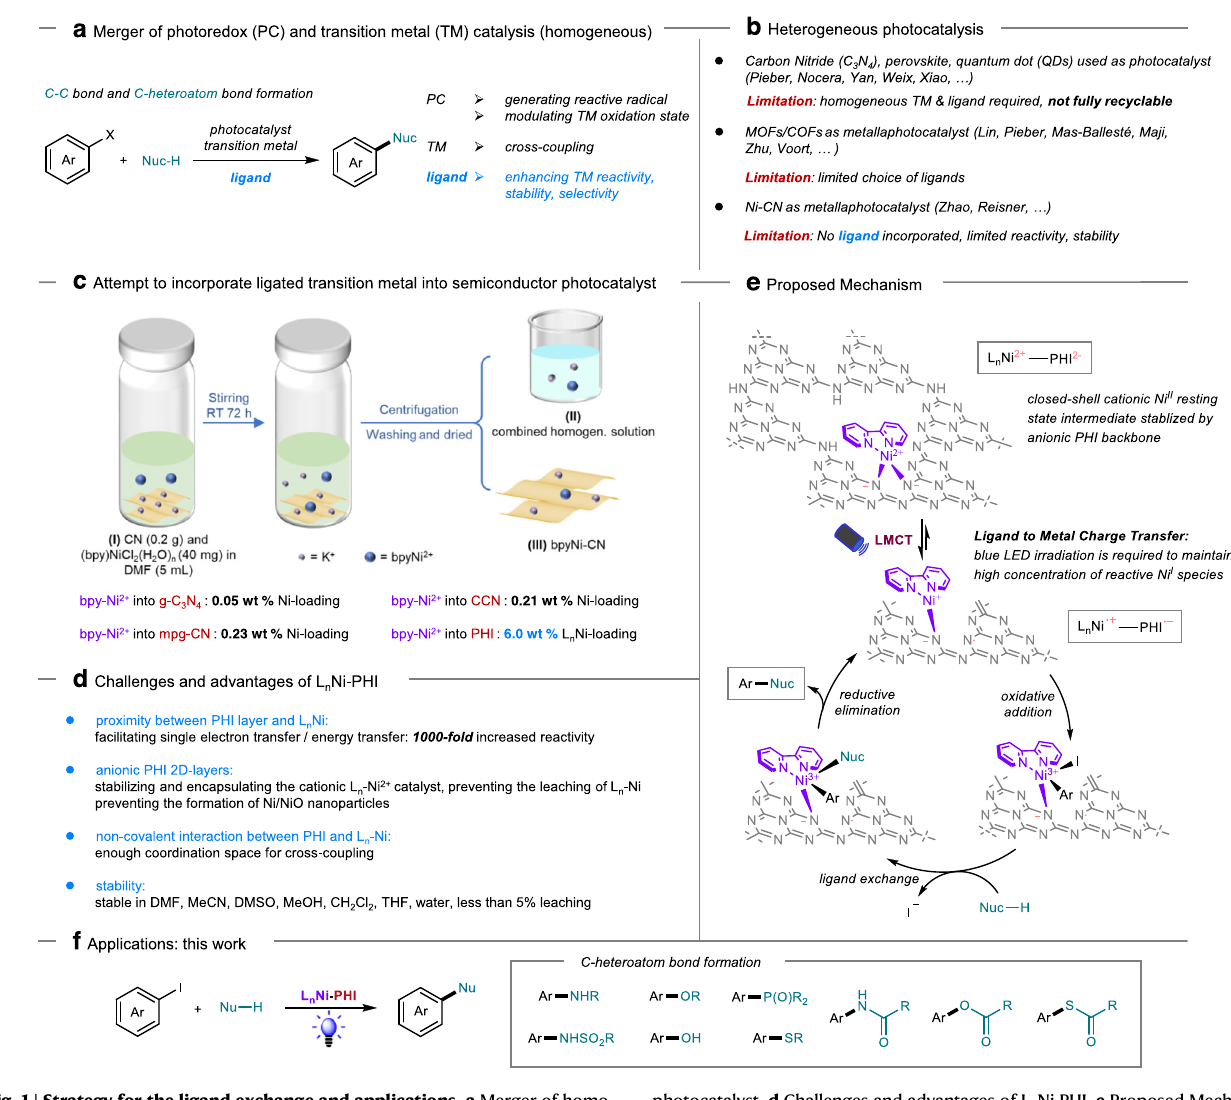
Fig. 1 | Strategy for the ligand exchange and applications. a Merger of homo- geneous photoredox and transition metal catalysis. b Heterogeneous photo- catalysis. c Attempt to incorporate ligated transition metal into